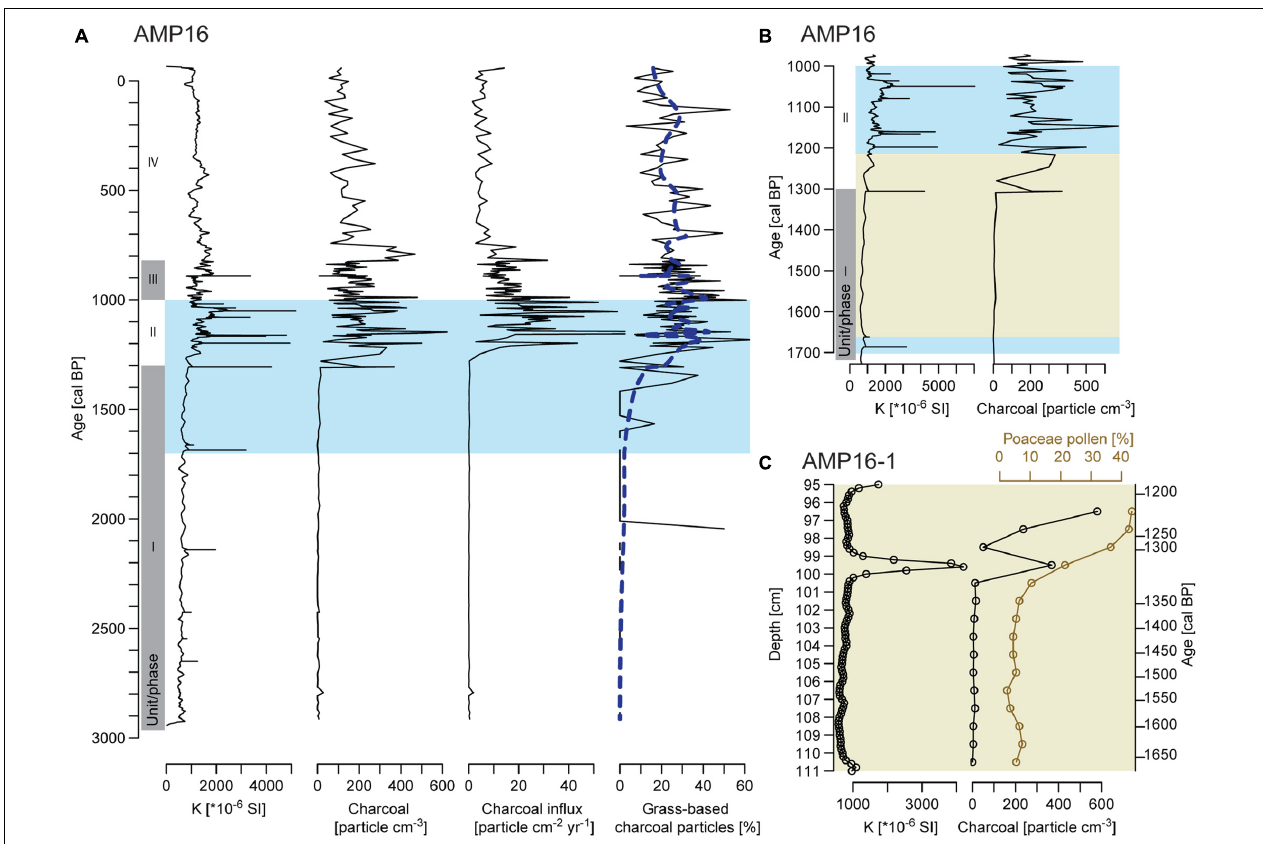
FIGURE 6 | (A) Comparison between records of magnetic susceptibility (K), macro-charcoal concentration, macro-charcoal influx and percentage of grass-based charcoal particles of composite record AMP-16. Blue dashed line represents the evolution of the proportion of grass-based macro-charcoal along depth estimated by applying a binomial generalized additive model smoother with a 25-degree-of-freedom thin plate regression spline basis (gam function in mgcv R package) to the dataset composed of each macro-charcoal depth and a value 0 for a wooden-based charcoal or 1 for a grass-based one. The blue area indicates the period selected in panel (B) showing precise comparison between magnetic susceptibility and macro-charcoal concentration of composite record AMP-16. The light green area indicates the period selected in panel (C) showing the transition zone recorded from core AMP16-1 and comparing magnetic susceptibility, macro-charcoal concentration and pollen percentages of Poaceae. Gray shaded areas on panels (A,B) demarcate sedimentological